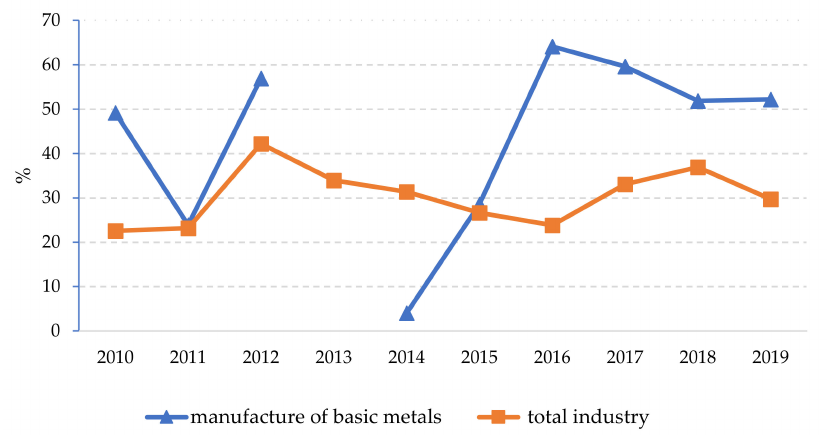
Figure 7. Shares of investment expenditure on R&D in total expenditures in the manufacture of basic metals compared with expenditures in the total industry in Poland. Source: adapted with permission from Refs. [101–109].